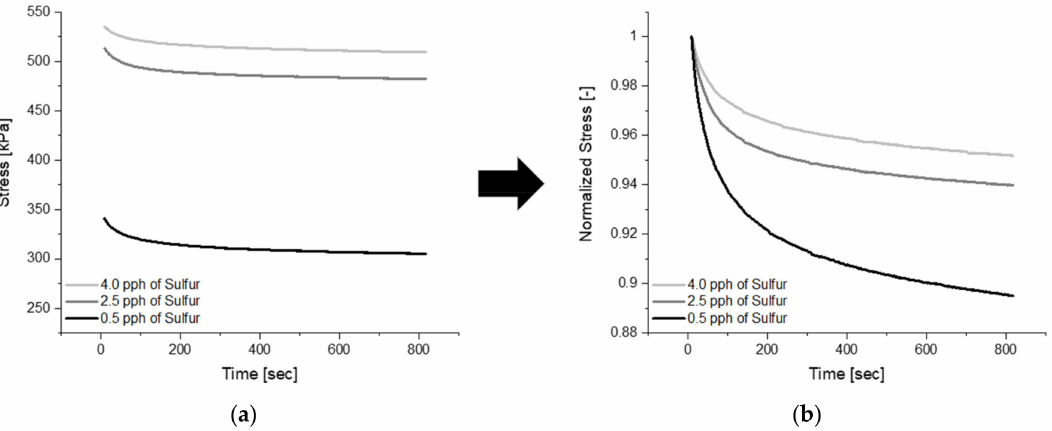
Figure 16. ( a ) Depicts relaxation curves for blends 7, 8 and 9 while ( b ) represents the normalized curves.